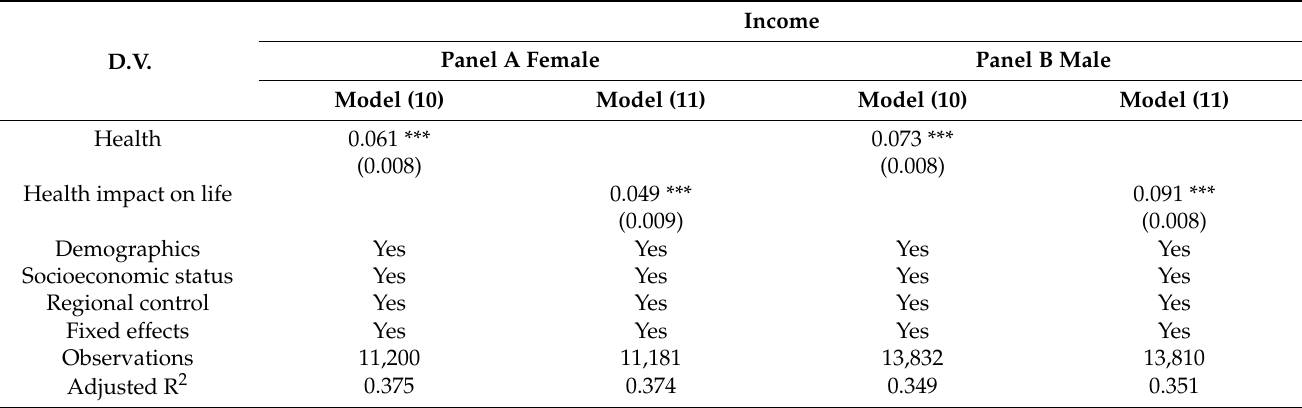
Table 7. Regression results of the health impact on